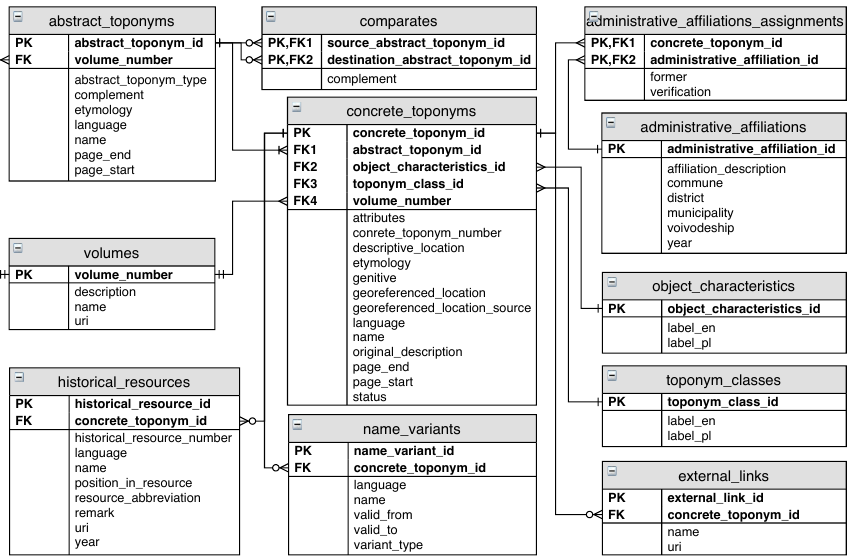
Figure 5. Entity-relationship model of